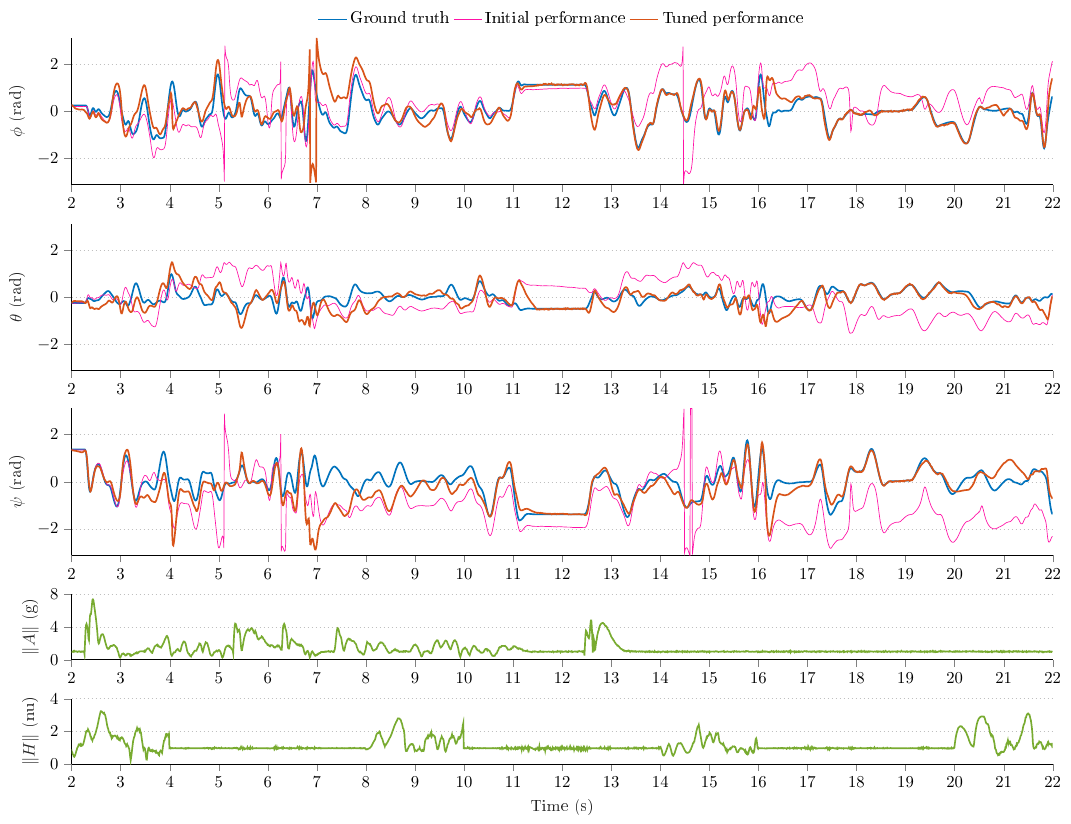
Figure 8. Initial and tuned performance of the gradient descent-based attitude